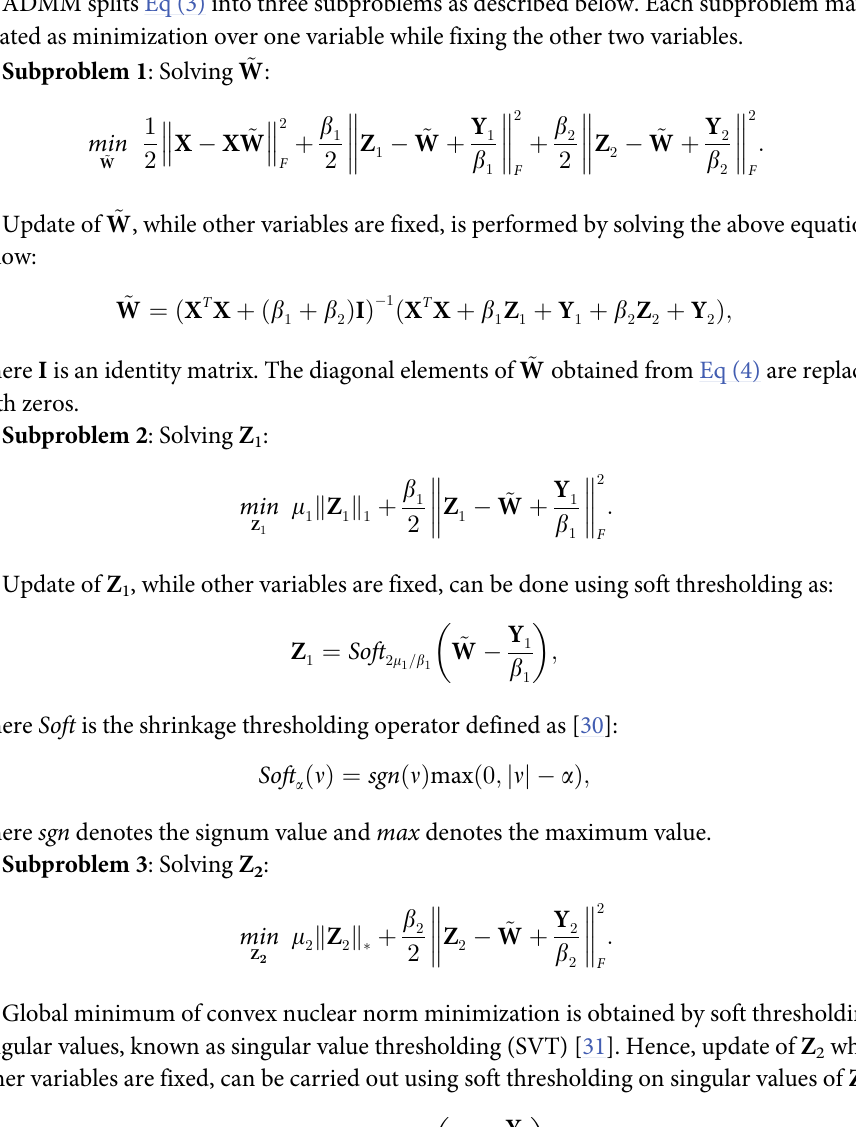
Algorithm 1 . LR-MVRC